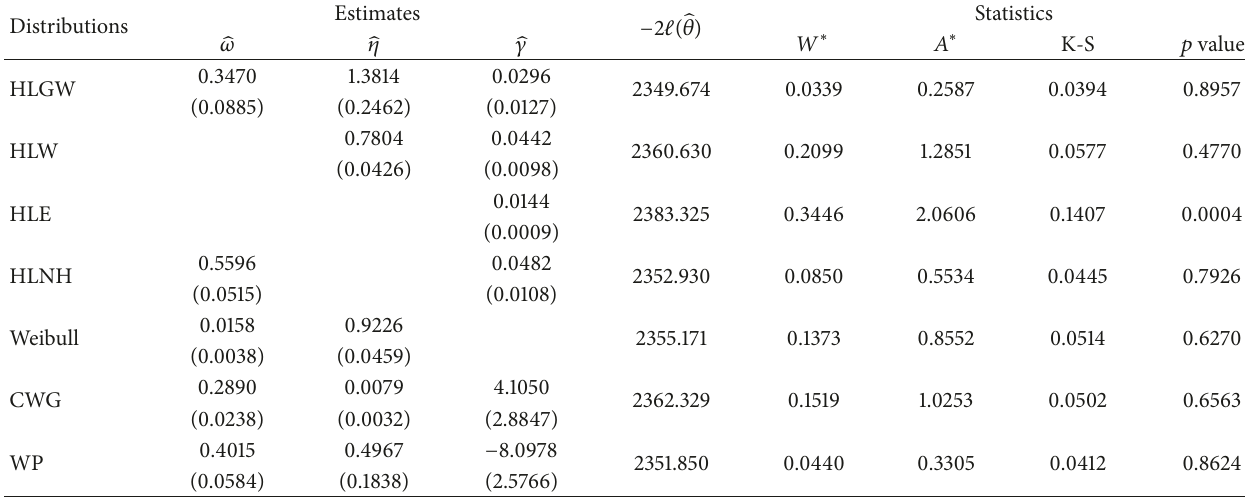
Table 3: Estimates of models for the air conditioning systems failure